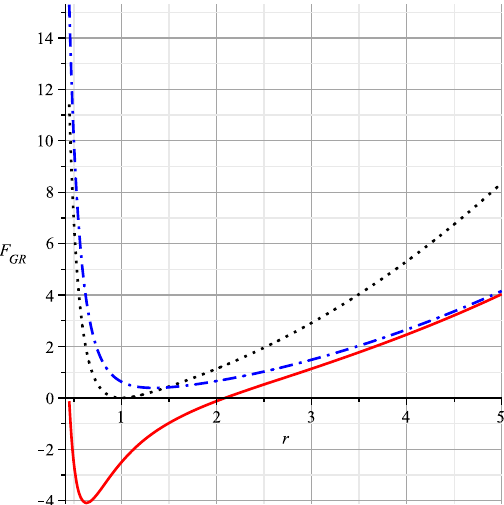
cases, the naked singularity solution is represented by a blue dashed- dotted line, the extremal black holes with a black dashed line and the solution with inner and outer horizons by a red continuous